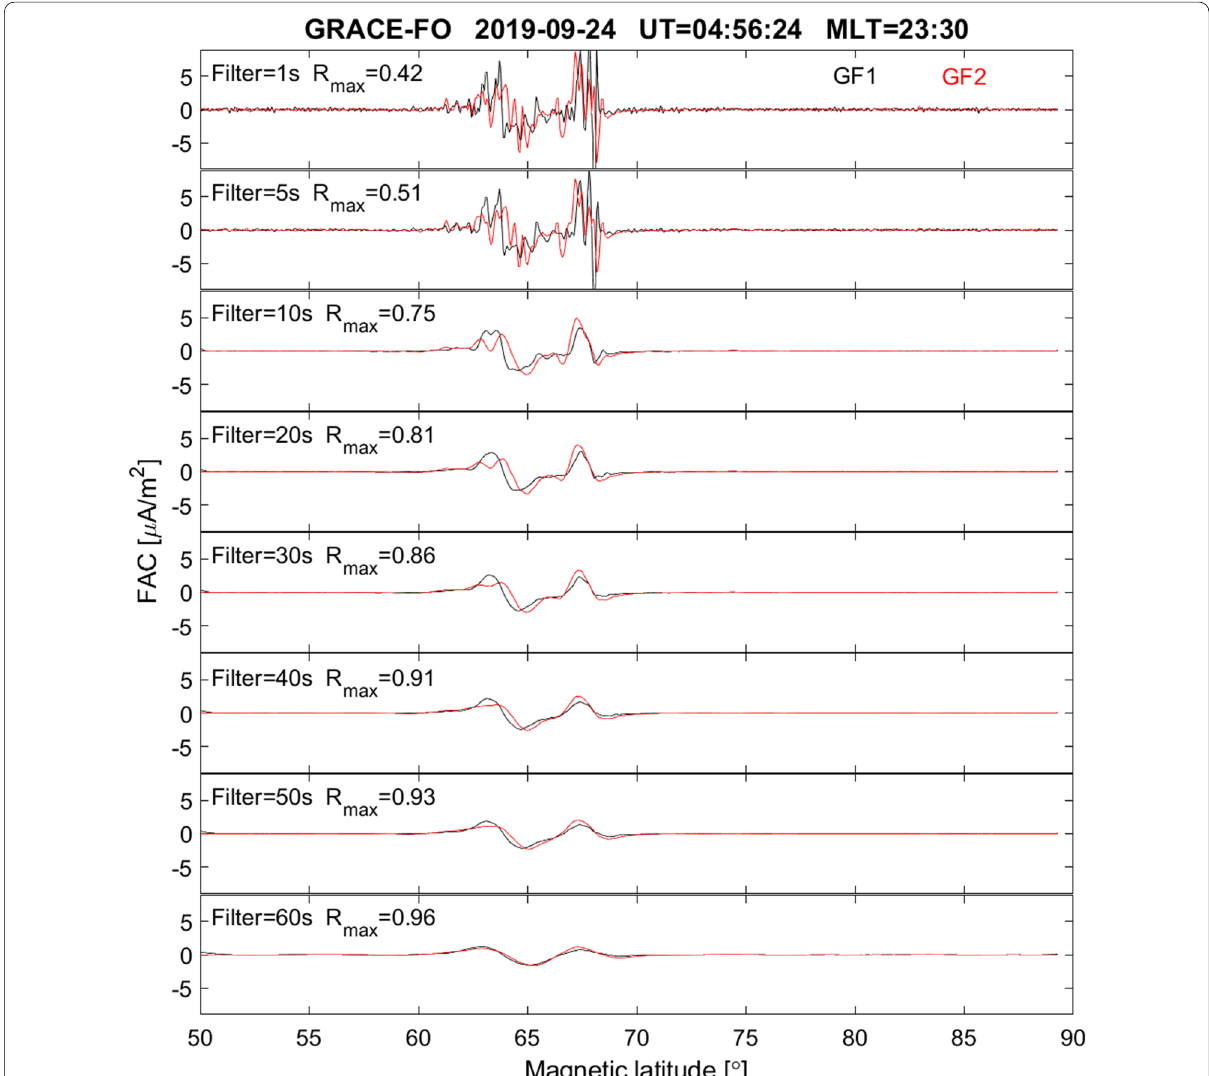
Fig. 9 One example of (top) the original FACs data at 1-Hz resolution, and (rest panels) the low-pass filtered time series at different cutoff